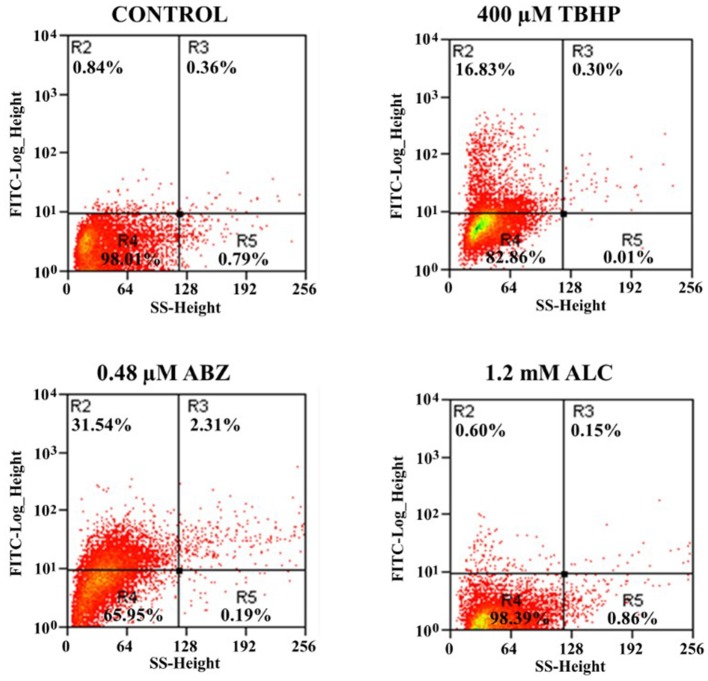
Allicin does not cause reactive oxygen species (ROS) formation in G. duodenalis trophozoites. Parasites (1 × 106) were exposed to 1.0% double distilled water pH 6.5 (Control) or the indicated concentrations of ALC, tert-butyl hydroperoxide (TBHP, positive control) or prooxidant ABZ for 24 h at 37°C then incubated with the ROS-monitoring agent H2DCFDH and processed by flow cytometry. Data shown in the figure are as follows: quadrants R2-R3 are cells positive for ROS and quadrants R4-R5 are cells negative for ROS. Percentages of total cells are indicated within each quadrant. The dot plots are representative of two independent experiments.